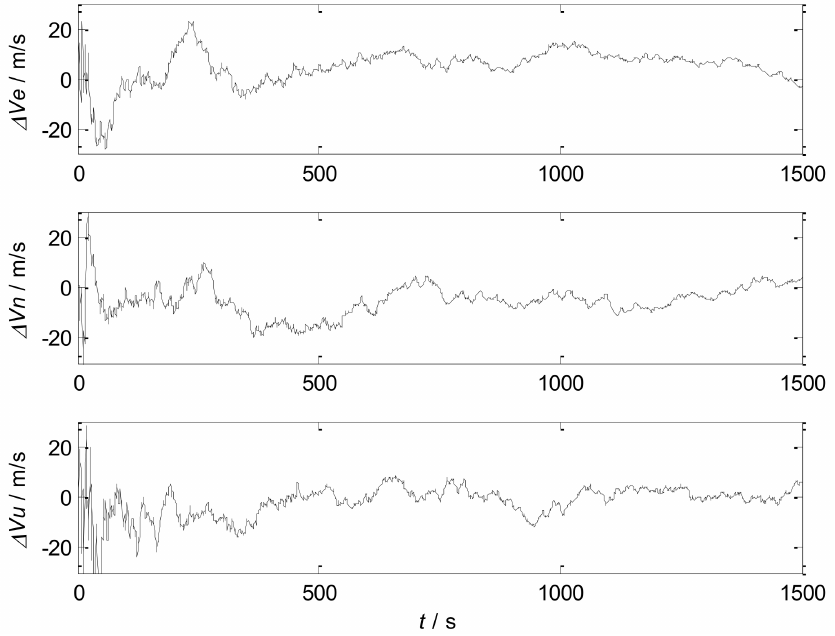
Figure 6. Velocity error of the autonomous integrated navigation system.